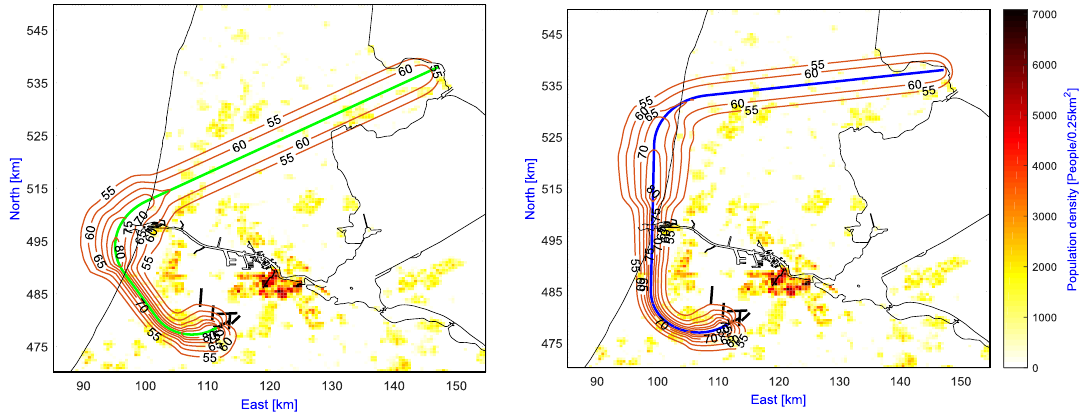
Figure 6. Noise level contours for cases 2 ( left ) and 3 ( right ).